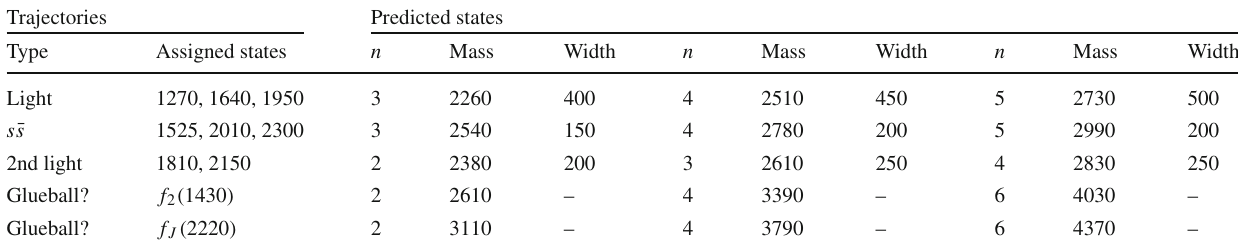
Table 10 The meson trajectories of f 2 as discussed in [4], with their excited states. The fitted slope here is 0 . 85 GeV − 2 , and half this value is used for the glueball trajectories. Widths are provided as estimates, based on proportionality of the width to the string length. However, the